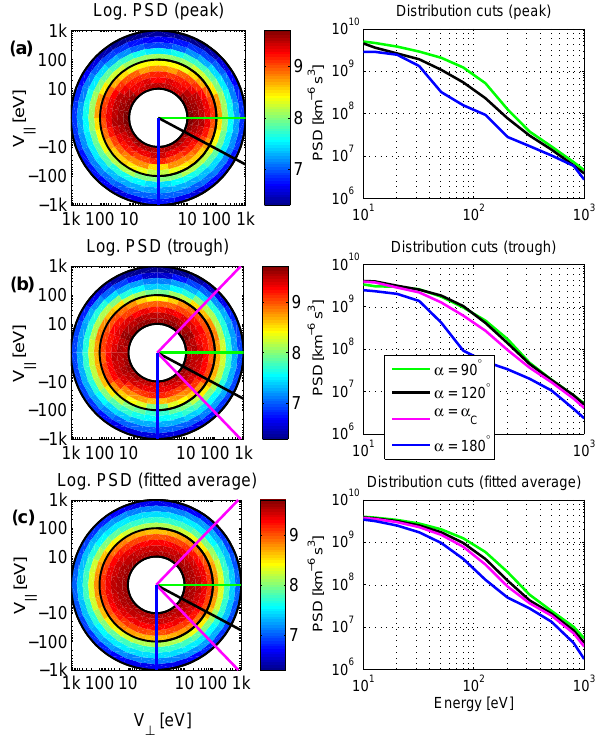
Fig. 7. Examples of the full 2-D distributions plotted as phase space density (without any normalization). The top panels show the ion distribution measured close to field maximum (a) and minimum (b) , corresponding to those in Fig. 6. The bottom panels (c) show the fitted distribution f Af . The right column shows cuts of the PSD at selected pitch angles; the respective pitch angles are visualized by lines of the same color in the corresponding 2-D